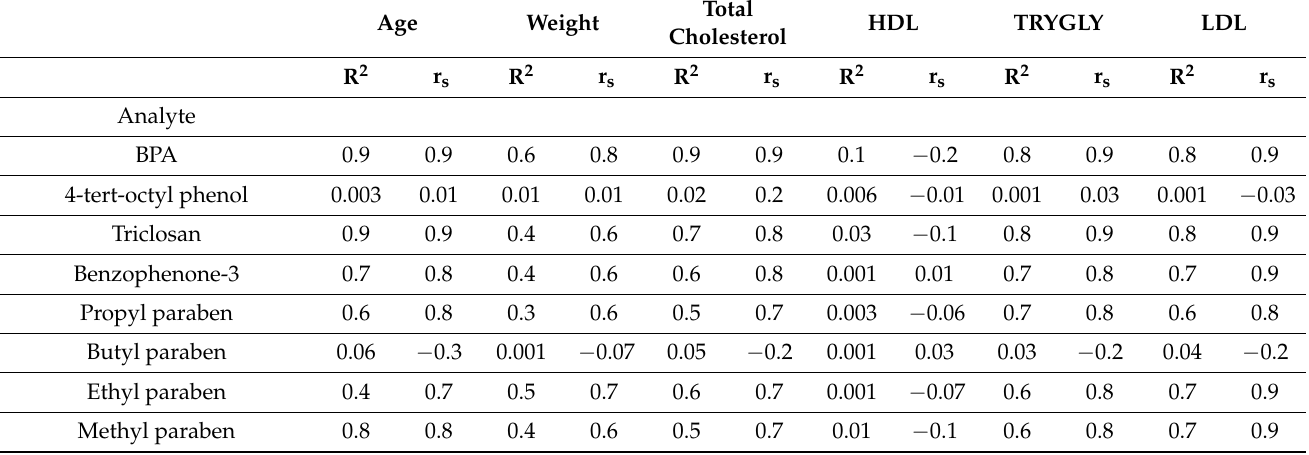
Table 5. Coefficient of determination (R 2 ) and Pearson correlation coefficients (r s ) between